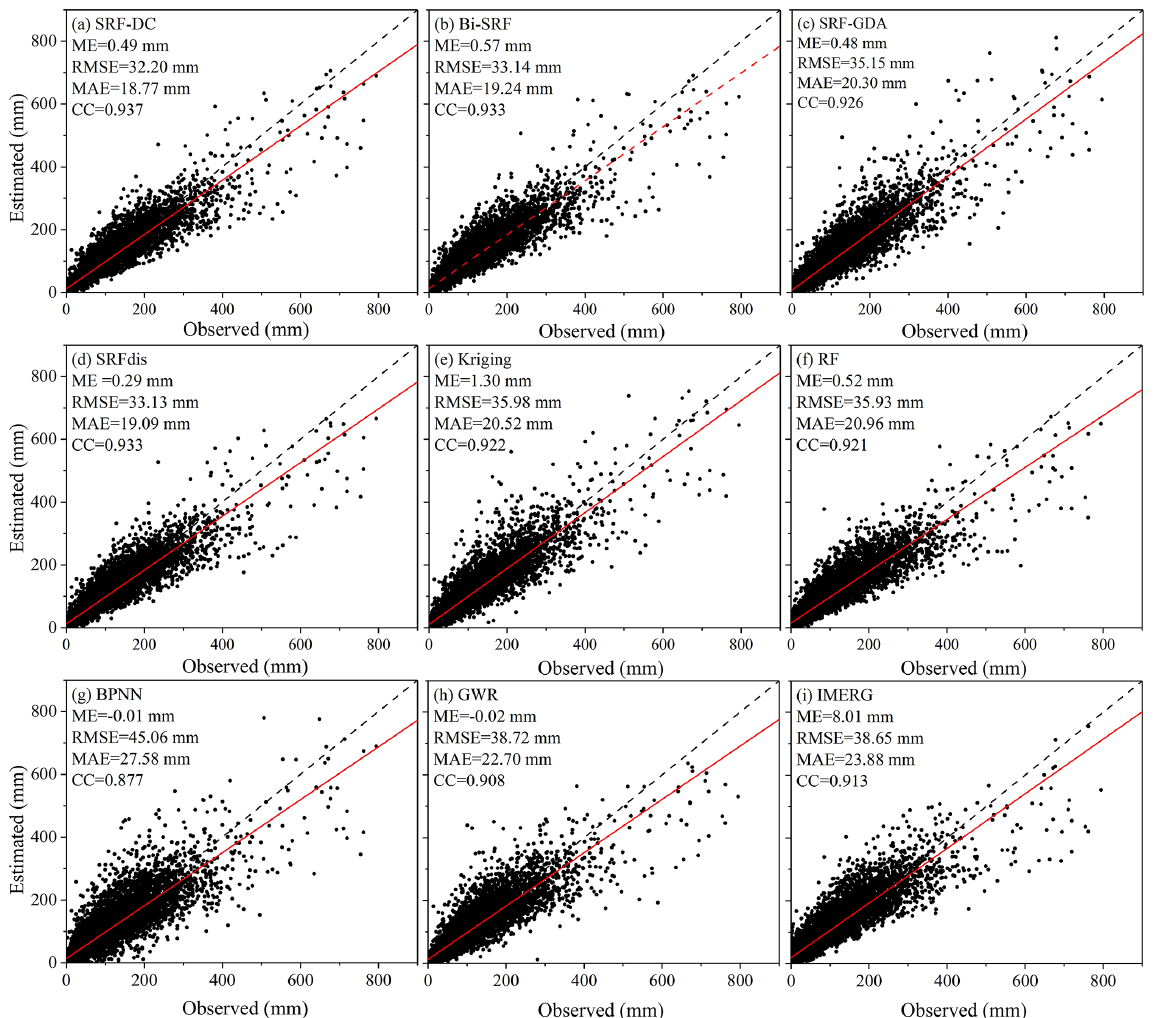
Figure 5. Scatterplots between the estimated and observed precipitation on a monthly scale from 2015 to 2019. Fitting line with the red color models the relationship between the observed and estimated